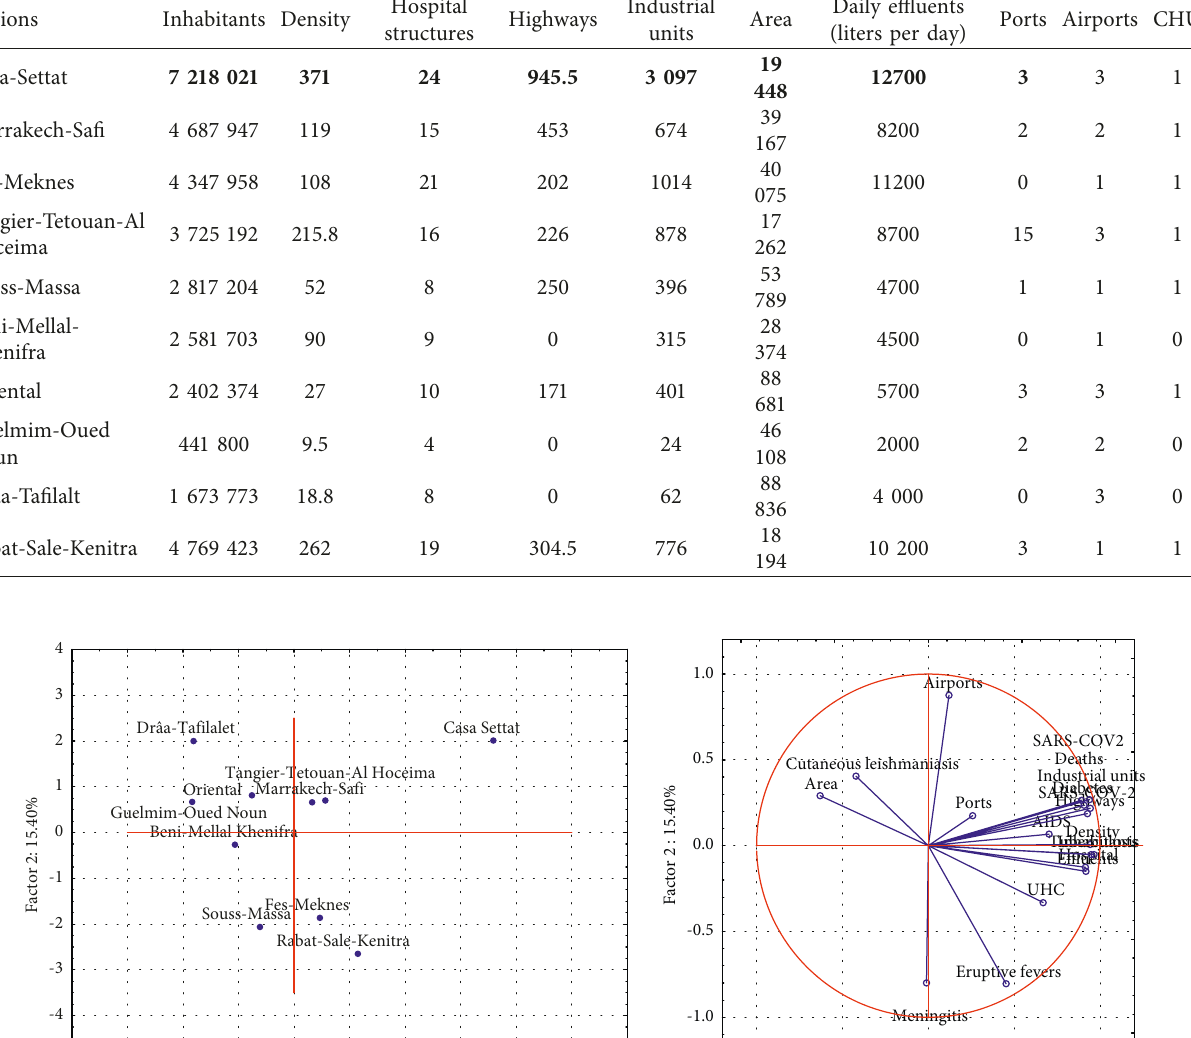
Table 2: Distribution of Moroccan regions according to their related epidemiological issues: constructed from data from monographs of 10 Moroccan